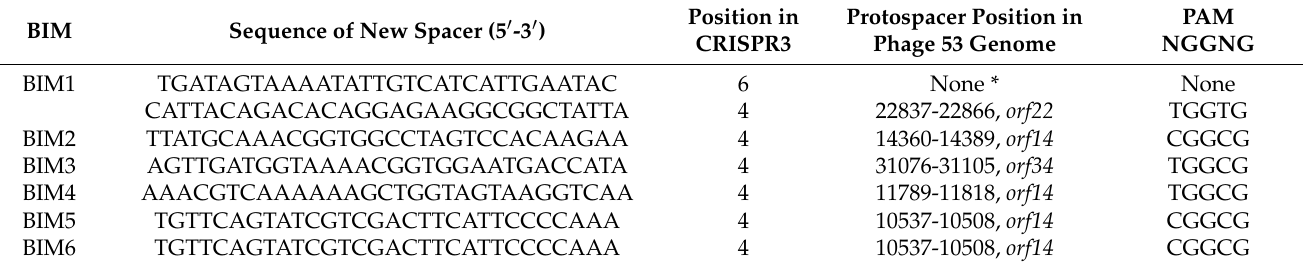
Table 1. Nucleotide sequence and position of newly acquired ectopic spacers in CRISPR3 of the BIMs obtained after a challenge with phage 53.